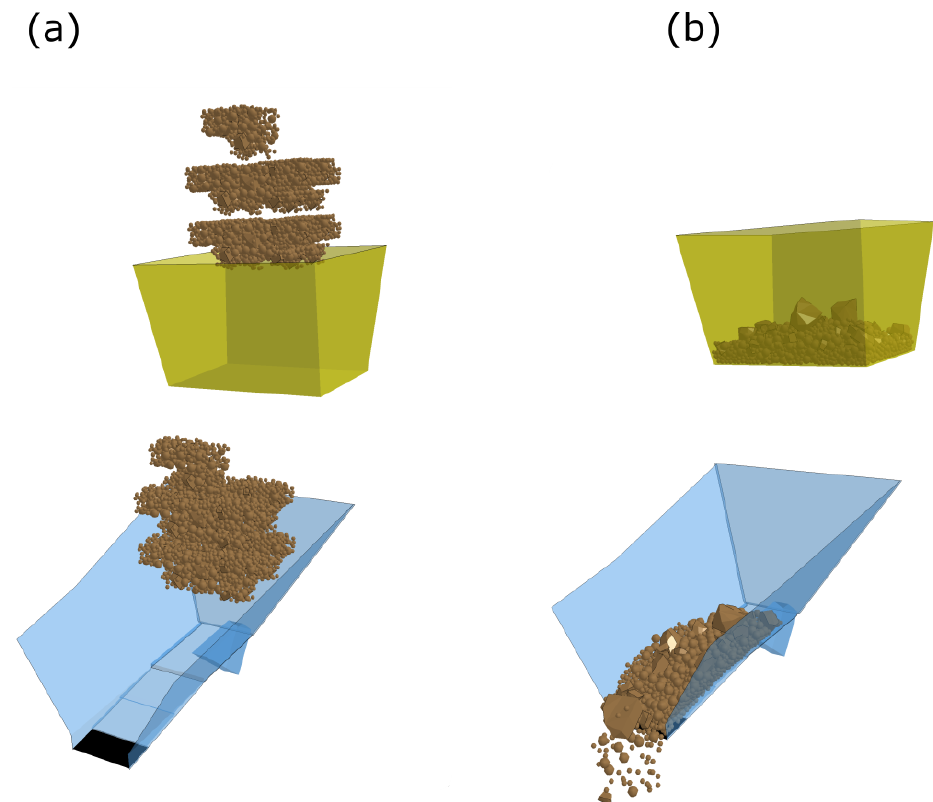
Figure 5. Presentation of the simulation model setup for the feeder. The initial setup ( a ), and after several seconds into the simulation ( b ). The black area represents the plates where wear is